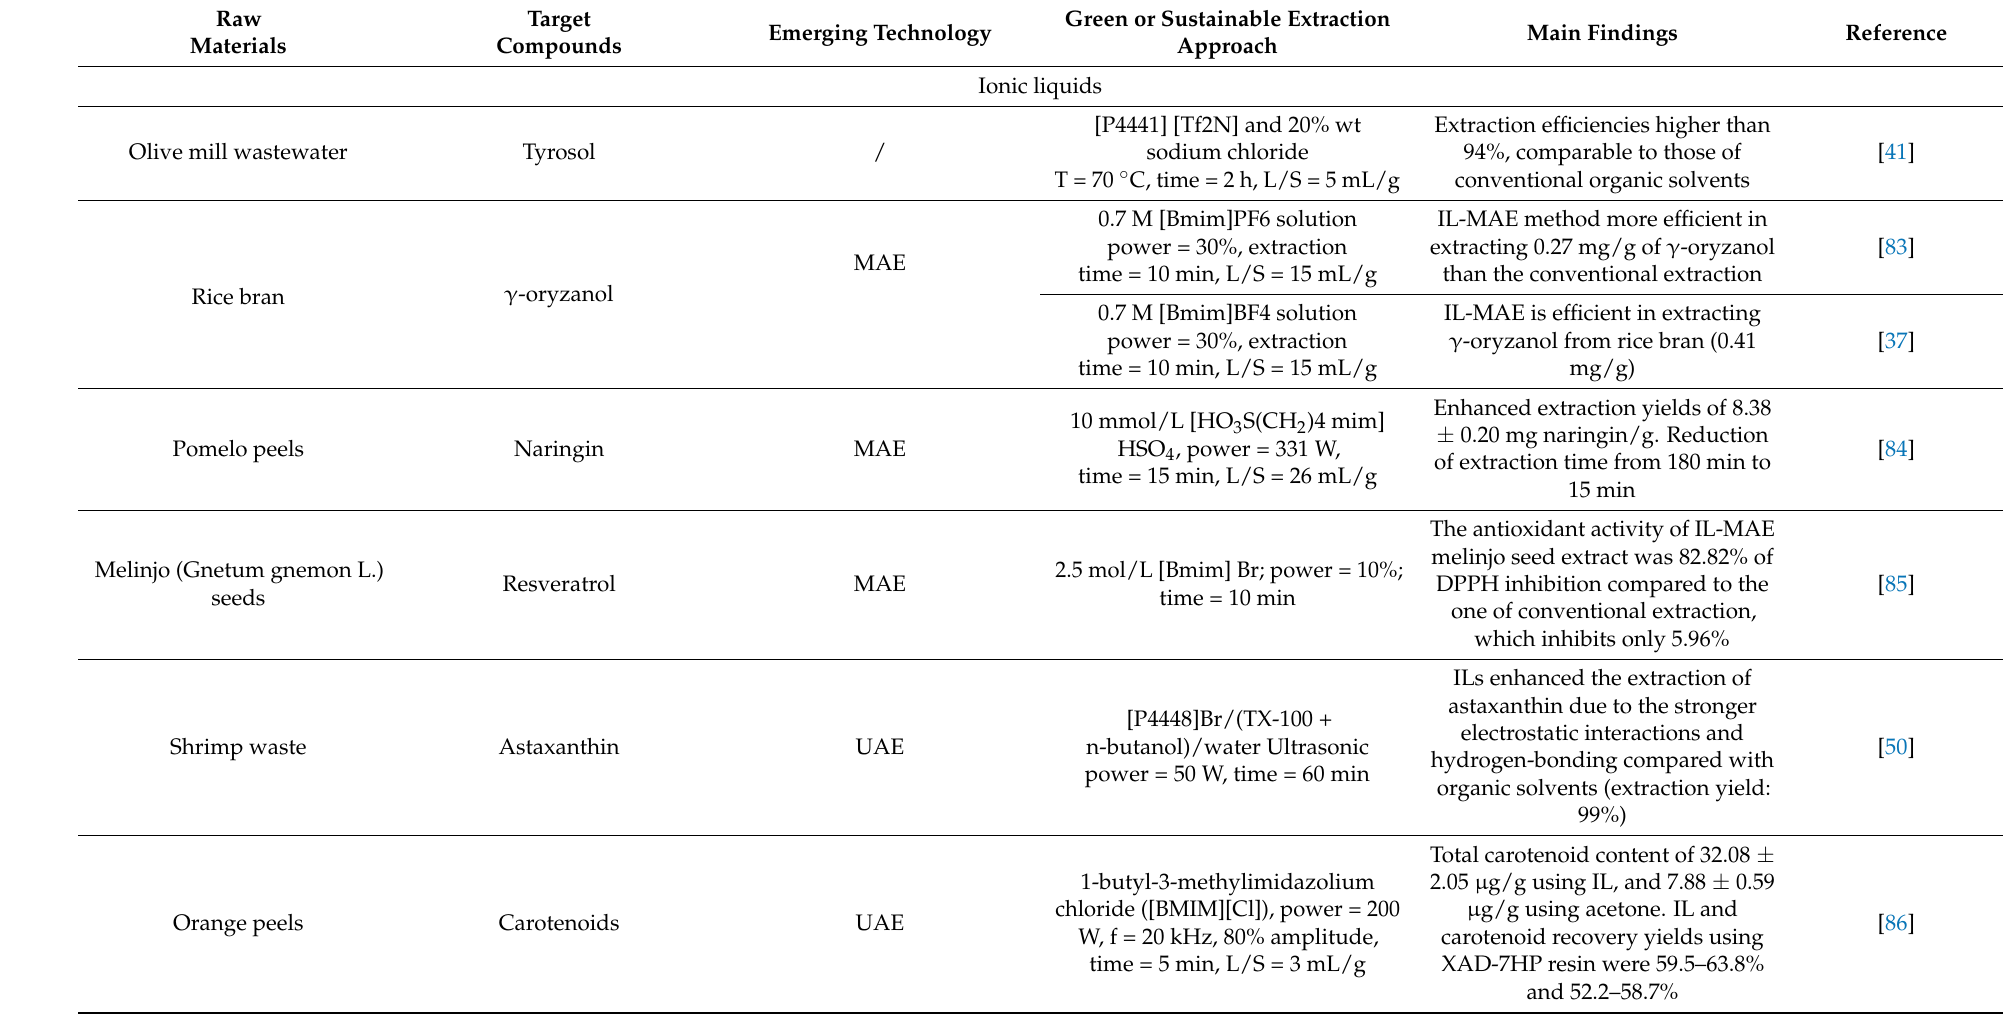
Table 4. Extraction of bioactive compounds from agri-food by-products using green solvents and/or assisted by non-conventional